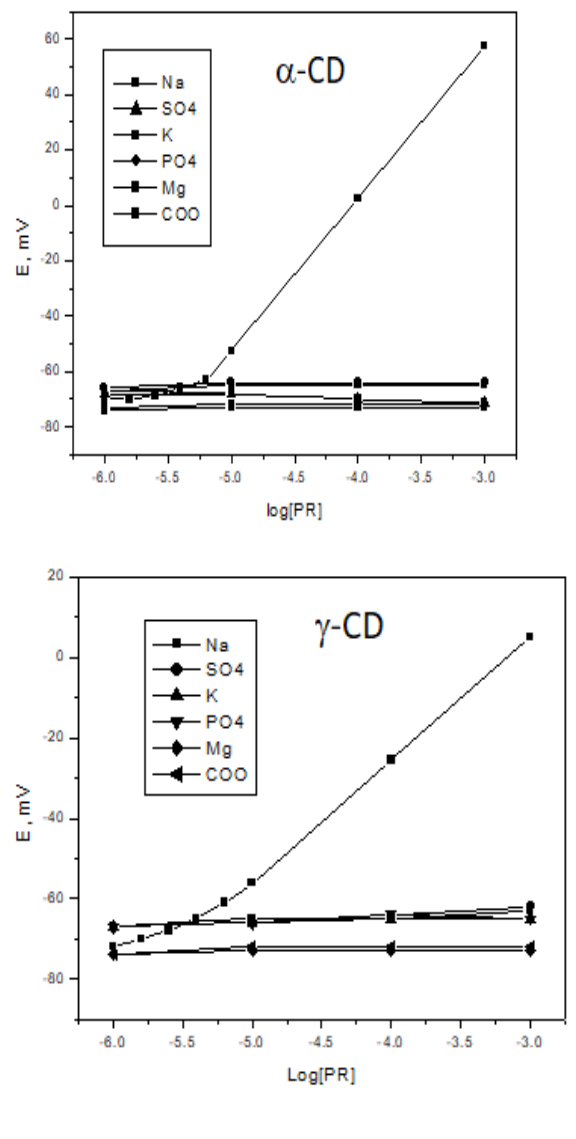
Figure 3: The effect of interference ions on the procainamide